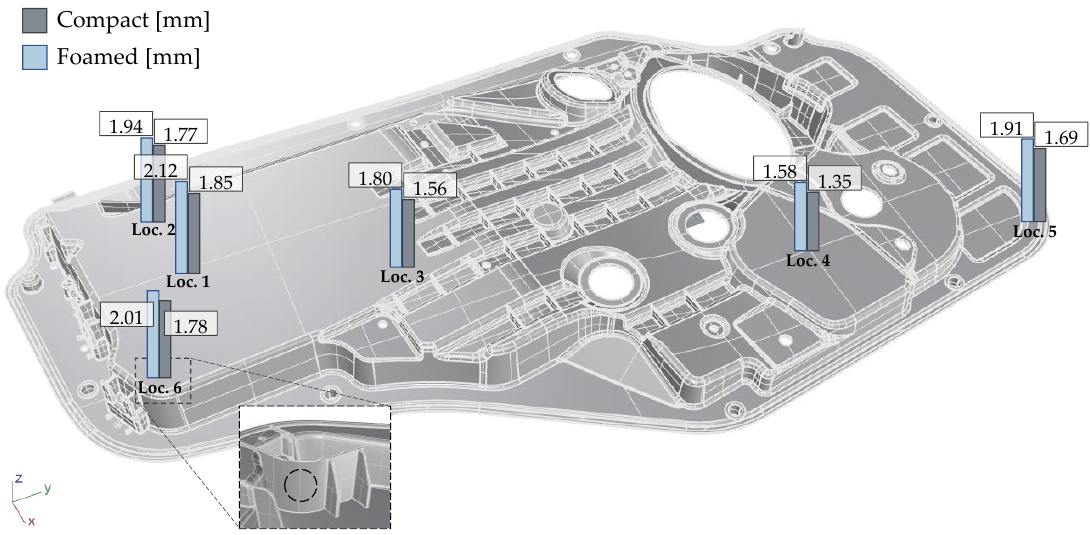
Figure 9. Global characteristic values L W of fiber microstructure.